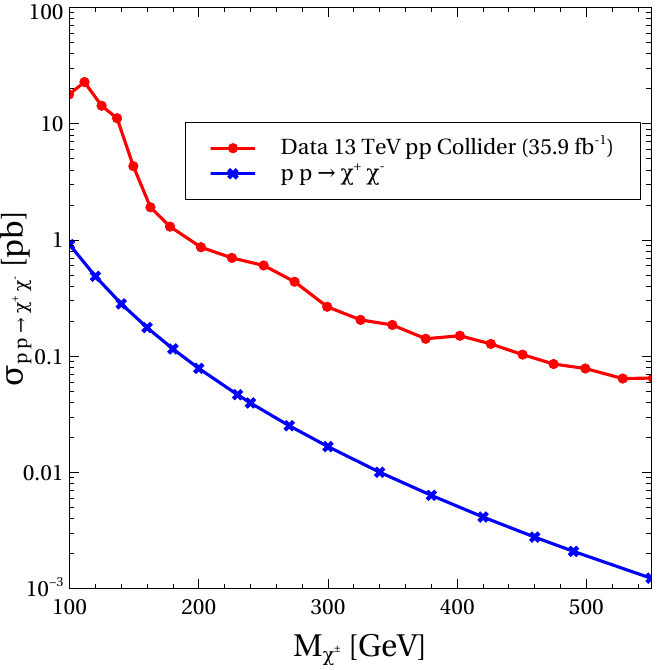
Figure 11 . Production of χ + χ − at the 13 TeV pp collider. Red line corresponds the bound for the production of singly charged fermion when we look for the l + l − + MET signal at the final state. Any model which predicts the production rate above the red line is already ruled